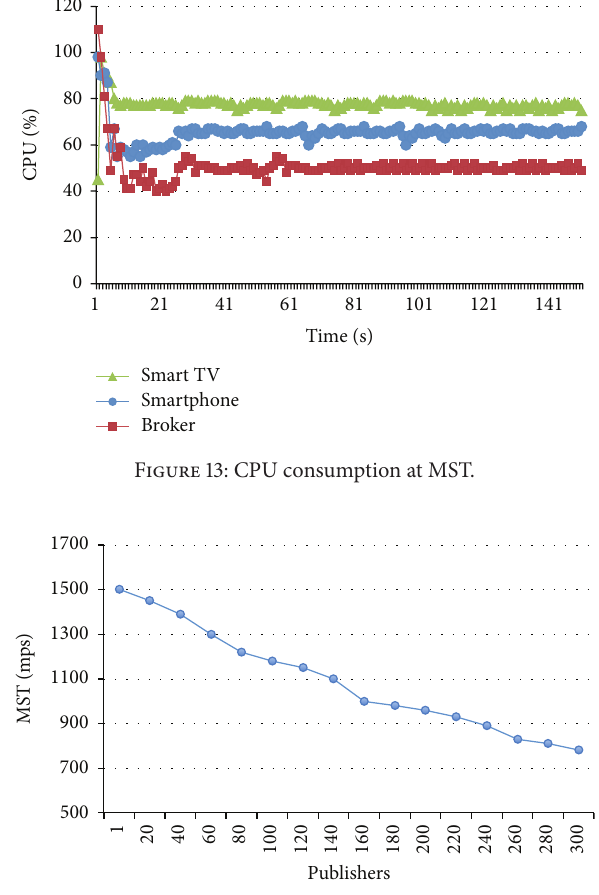
Figure 14: MST versus number of publishers.